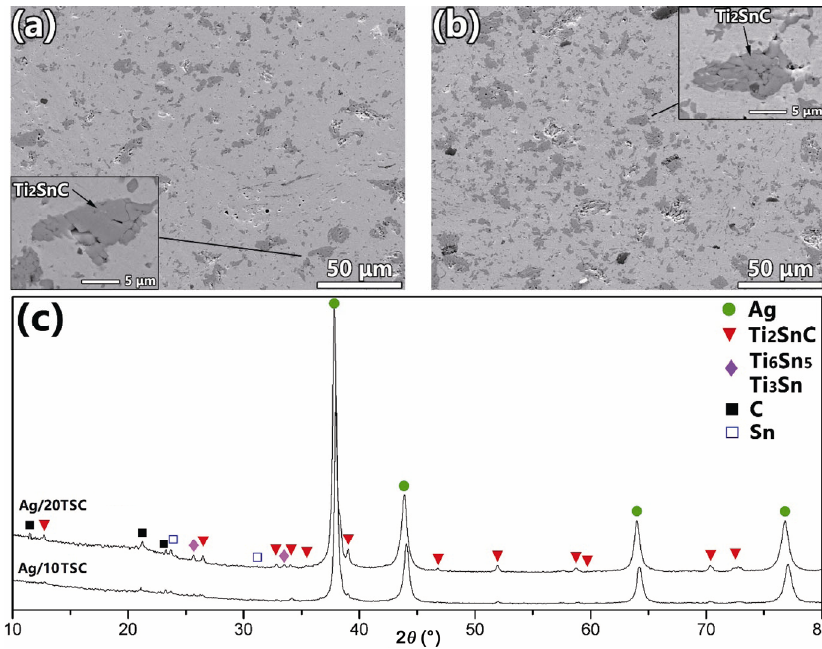
Fig. 2 Microstructures of (a) Ag/10TSC and (b) Ag/20TSC composites. And the insets are the enlarged images of Ti 2 SnC. (c) XRD patterns of Ag/10TSC and Ag/20TSC